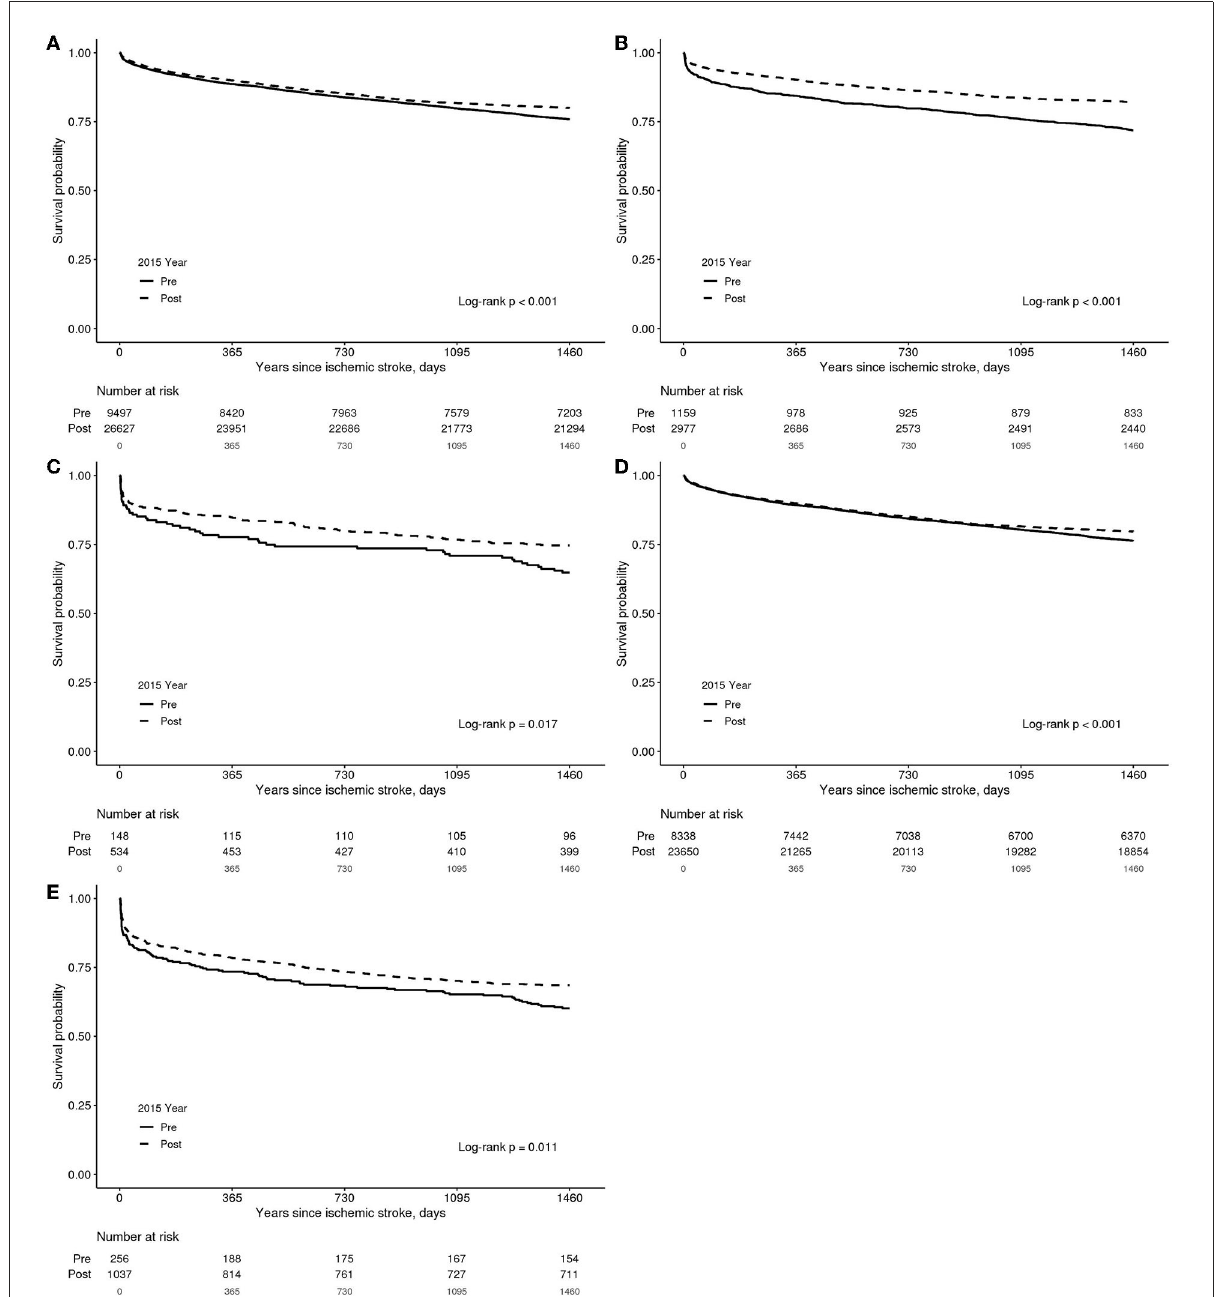
FIGURE2 A Kaplan–Meier estimate in patients with acute ischemic stroke according to observation groups. (A) Total patients. (B) Patients who underwent intravenous thrombolysis. (C) Patients who underwent both intravenous thrombolysis and mechanical thrombectomy. (D) Patients who did not undergo intravenous thrombolysis. (E) Patients who underwent mechanical thrombectomy.